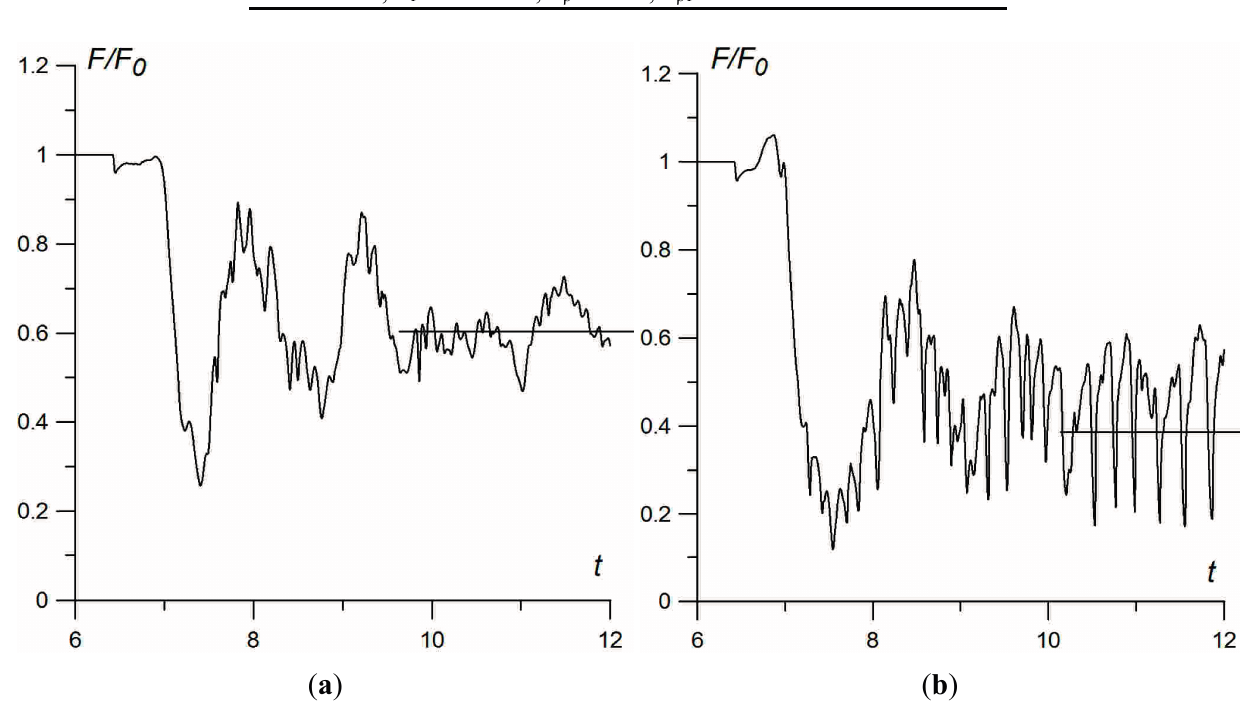
Figure 7. Dynamics of dimensionless frontal drag force, M = 3, α ρ = 0.65: ( a ) Non-combined filament; ( b ) Combined filament, α ρ 1 =